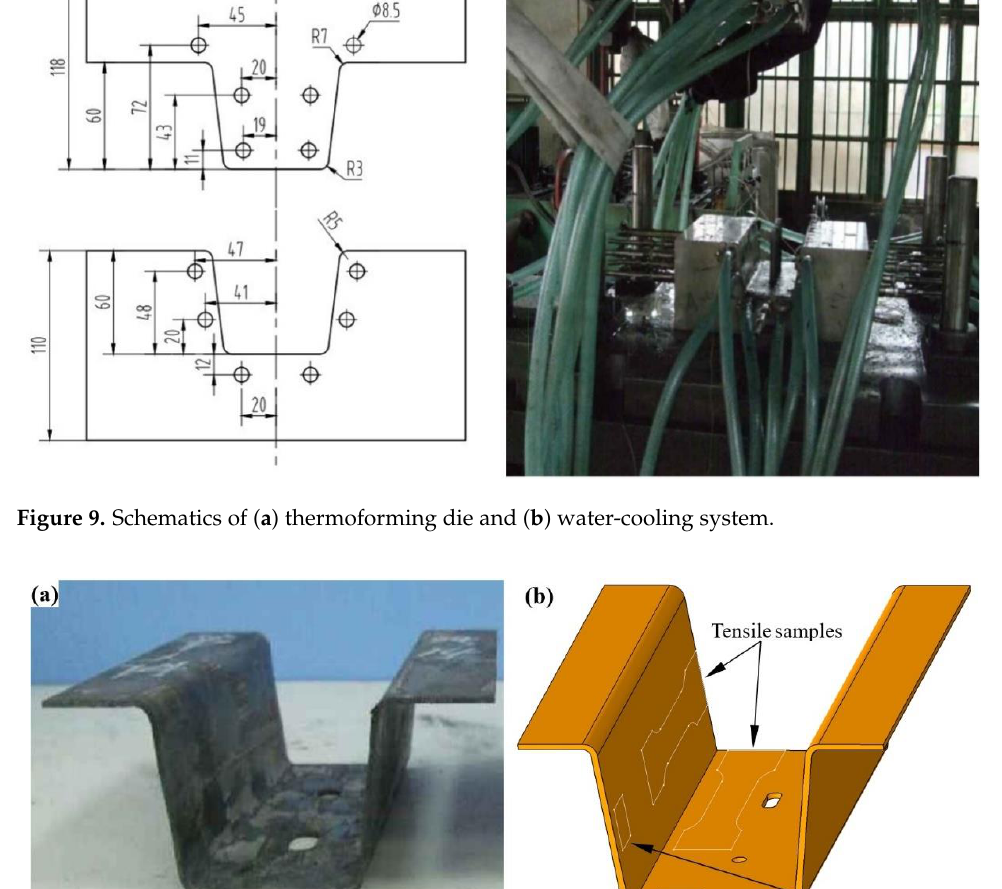
Table 2. Averaged dimensions of the thermoformed U-shaped part. Sheet Thickness Total Height Bottom Width Opening Width a Figure 10. ( a ) Thermoformed U-shaped part and ( b ) schematic of sampling location.